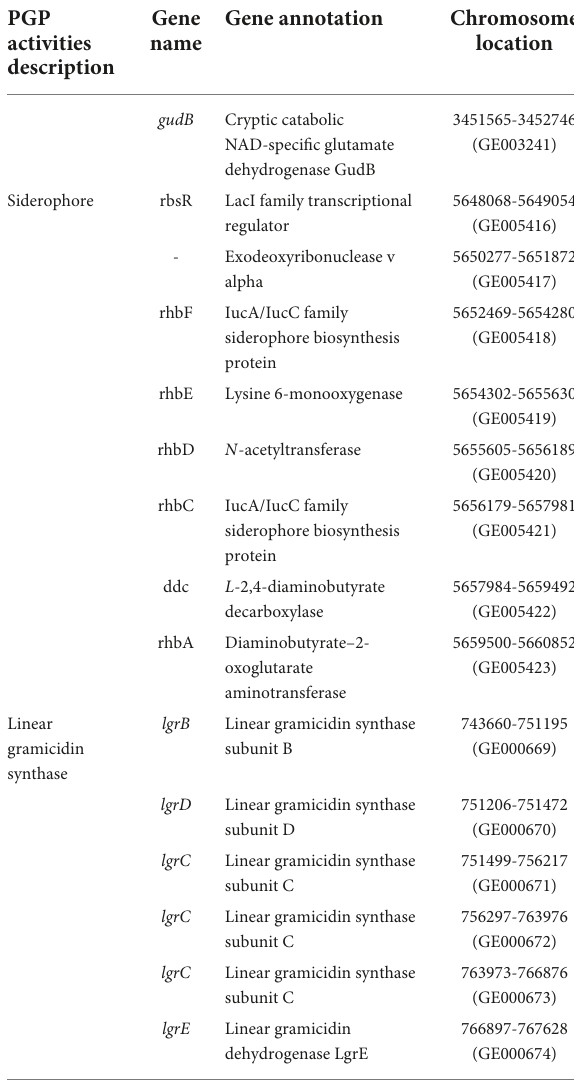
TABLE 3 Predicted genes associated with PGP in Q2H1